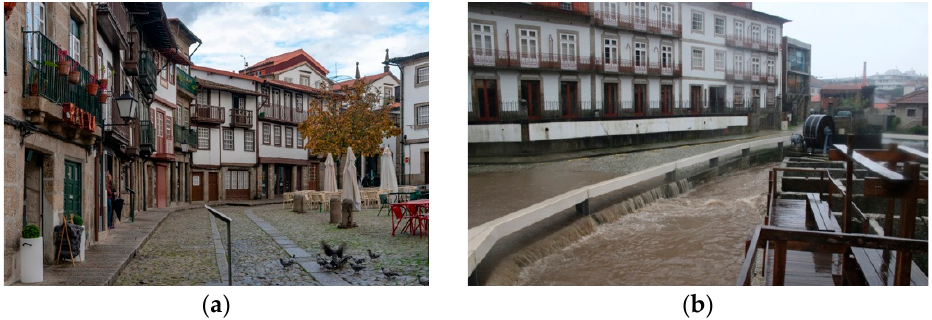
Figure 1. The Historic City Centre of Guimarães: ( a ) View to one of its squares; ( b ) Example of a flood event in the Couros’ river basin (source: Guimarães City Council).